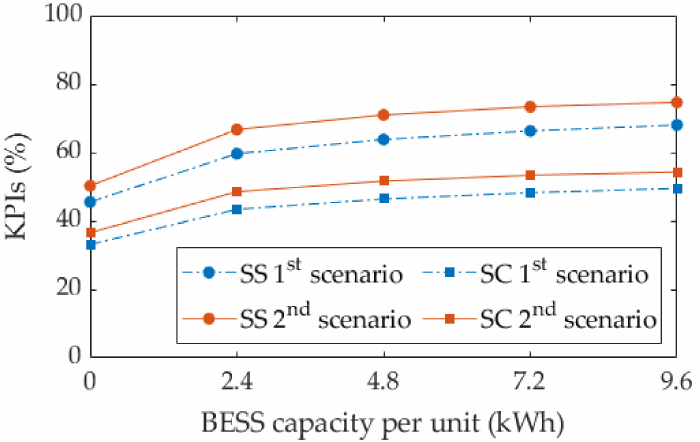
Figure 13. Annual self-sufficiency and self-consumption of the facility as a function of BESS capacity per unit in the two scenarios.